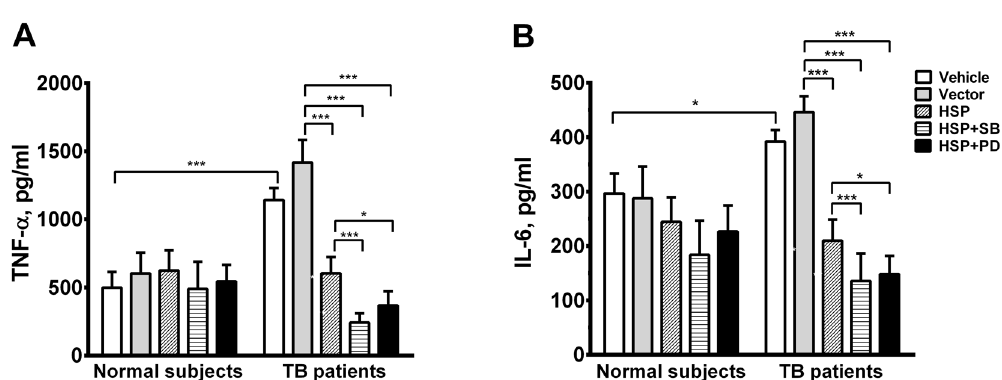
Figure 5. Levels of TNF- α ( A ) or IL-6 ( B ) secreted from AM of TB patients (n = 10) and normal subjects (n = 7) incubated in culture medium (Vehicle), or transfected with vector alone (Vector), or transfected with HSP70 plasmid (HSP) in the absence or presence of a p38 kinase (SB) or ERK kinase inhibitor (PD). *** p < 0.001, ** p < 0.01, * p <